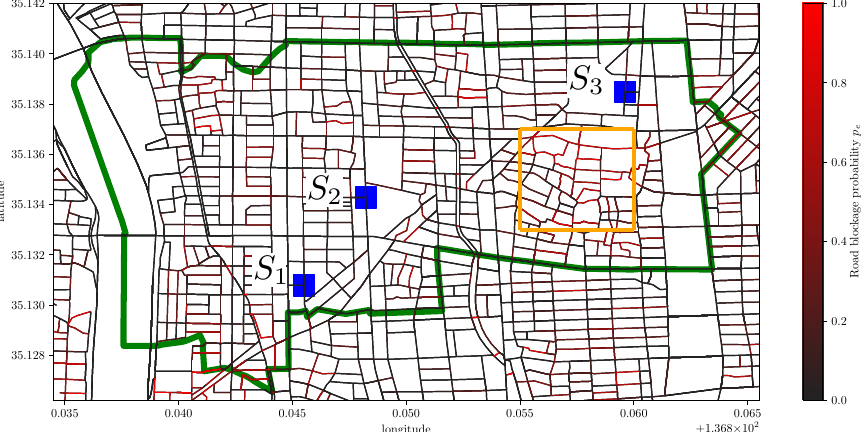
Figure 2. The map of Arako district covered by the green polygon (2.7 [ km ] blockage probability, and refuges blockage probabilities.